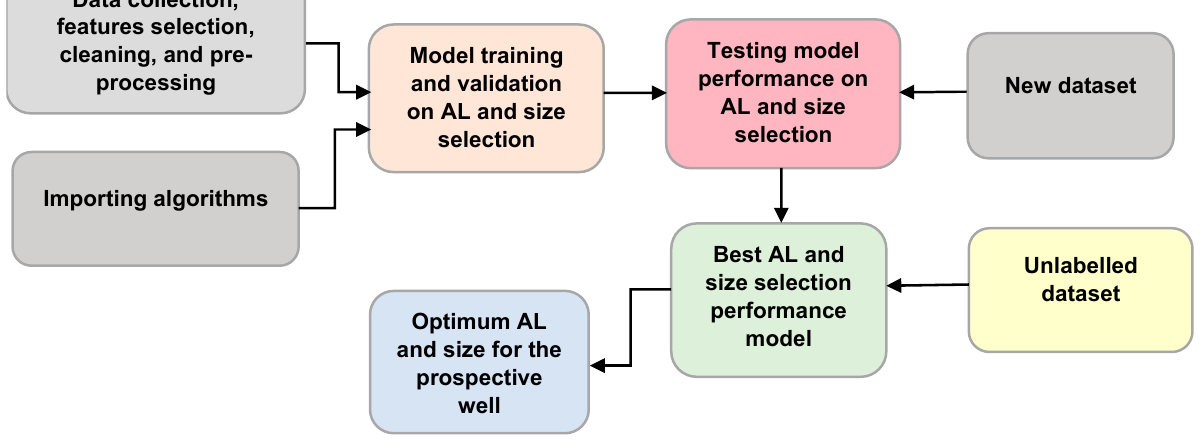
Figure 4. AL and size selection work fl ow.